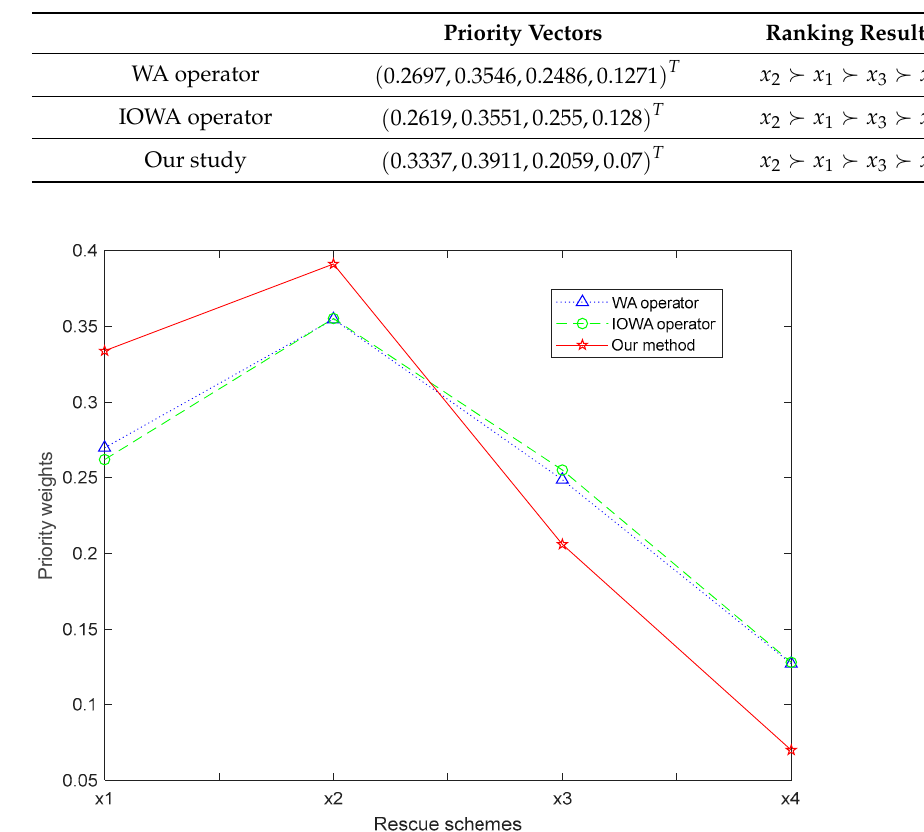
Figure 2. The priority weights of four rescue schemes from three methods.